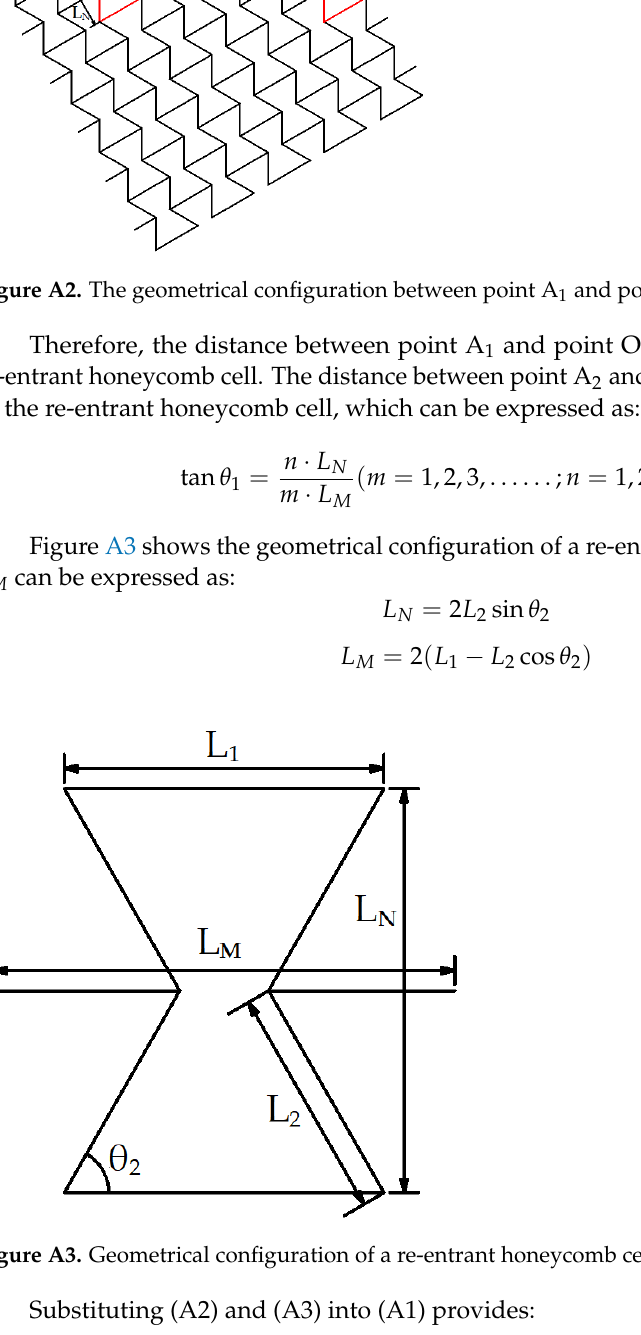
To find a real number k to make , the expression (A4) can be ex- pressed as: